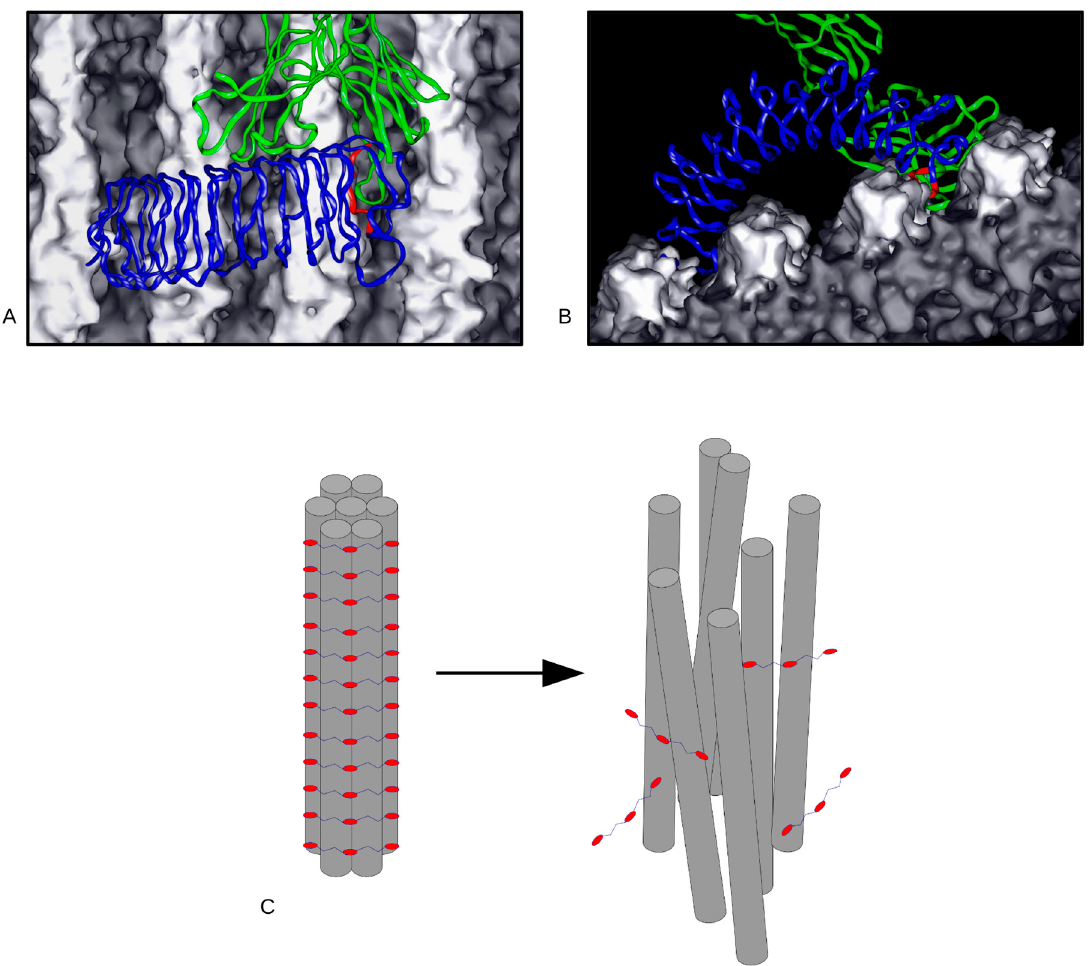
Figure 1. ( A , B ) show coordinate models of the interaction of an extracellular matrix LRR proteoglycan (Biglycan, blue), analogous to LRRC15, in its structural role in maintaining fibril-bundle integrity ( C ). Under certain circumstances, antibodies can disrupt this interaction. Antibody fragment binding is shown in ( A , B ) and colored green, with a competitive protein-protein interaction between antibody, the LRR protein core (epitope colored red), and fibrils in the fibril bundle (collagen molecules colored light and dark gray). ( C ) shows the disruption to the ECM that occurs under these conditions [14], where proteoglycans are dis-engaged from the fibril bundle, undoing the structure. Conflicts of Interest: The authors declare no conflict of